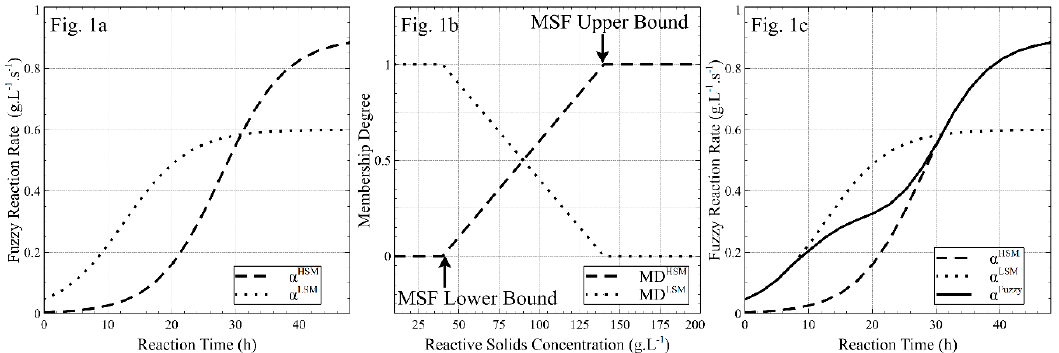
Figure 1. Fuzzy model (FM) reaction rate calculation—( a ) Example rates for independent high solids model (HSM) and low solids model (LSM); ( b ) Example of membership function (MSF) for high solids model (HSM) and low solids model (LSM); ( c ) Resulting hypothetical fuzzy model (FM) rate from high solids model (HSM) and low solids model (LSM) rates.